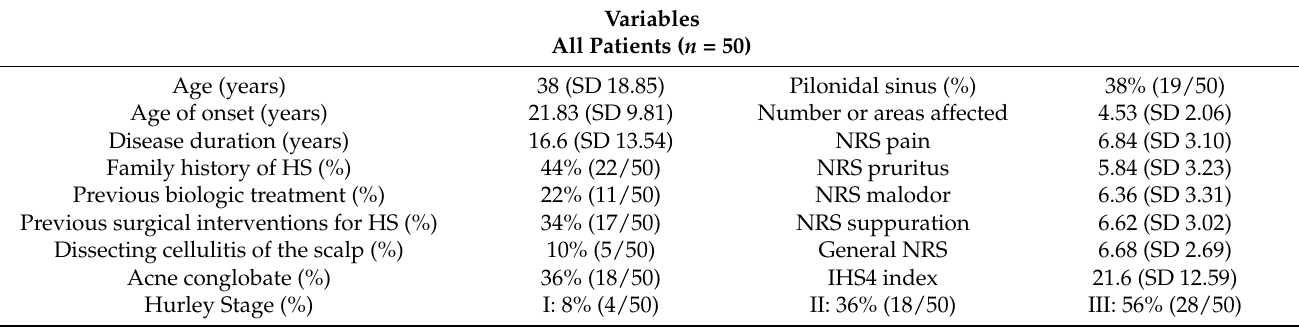
Table 1. Socio-demographic and clinical features of the sample.